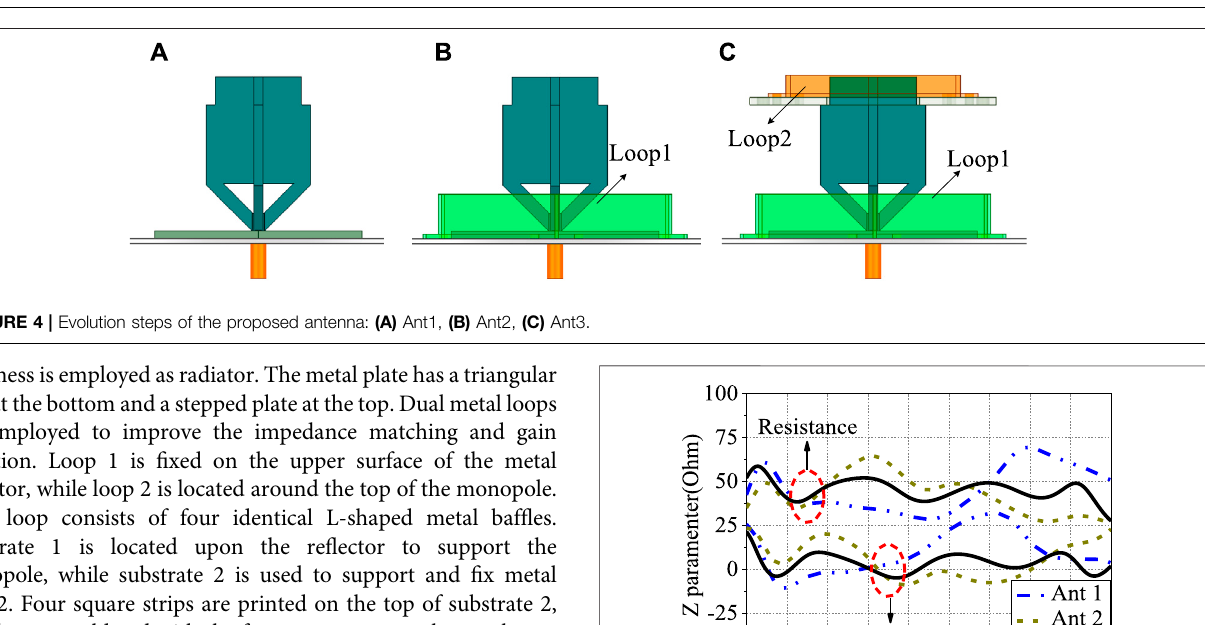
FIGURE3| Simulated results ofdifferentmonopoles: (A) re fl ection coef fi cient, currentdistributionat 5.1 GHz ofmonopoles withdifferentsector number N (B) N= 2, (D) N = 3, and (D) N = 4, (E) gain variation.